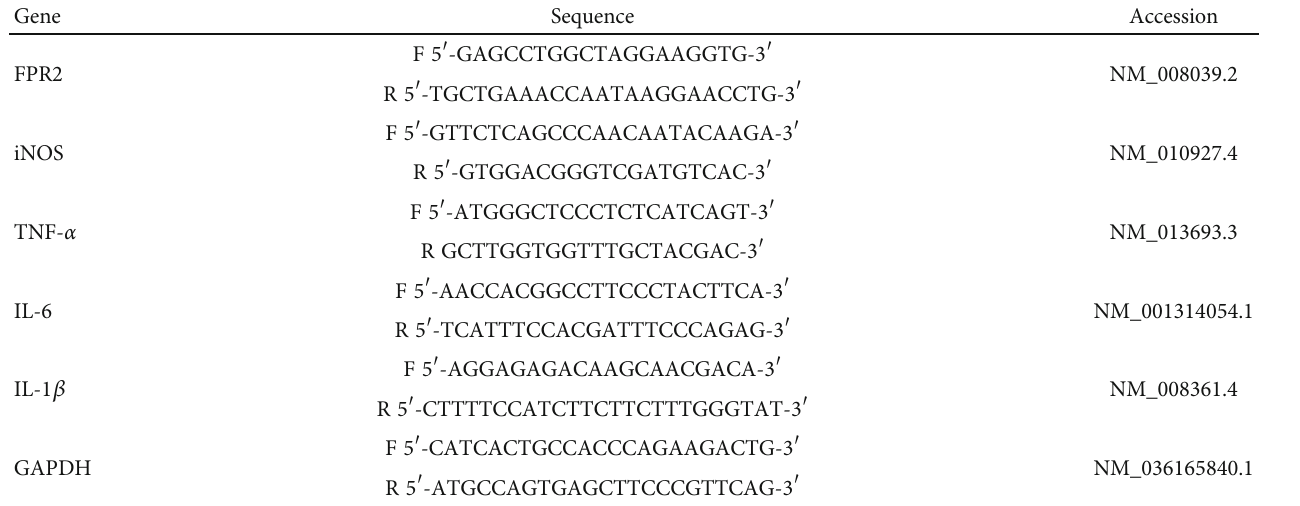
Table 1: PCR primers in this